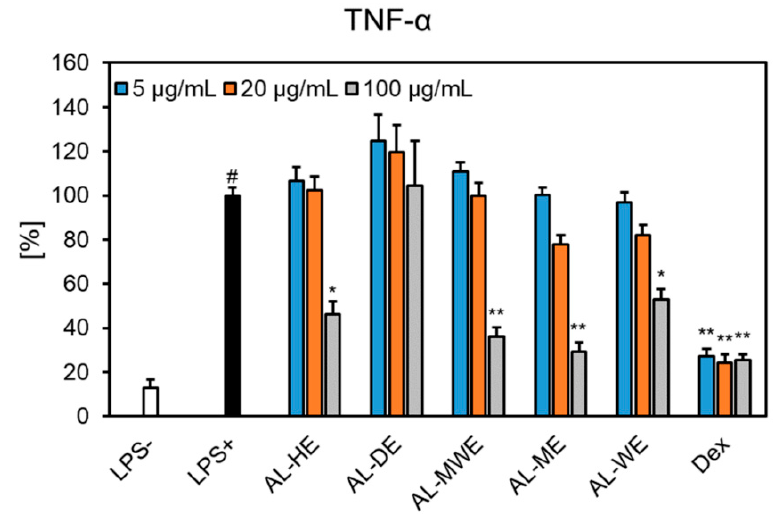
Figure 8. The effects of Artemisia campestris subsp. lednicensis extracts (5–100 μ g/mL) and dexame-